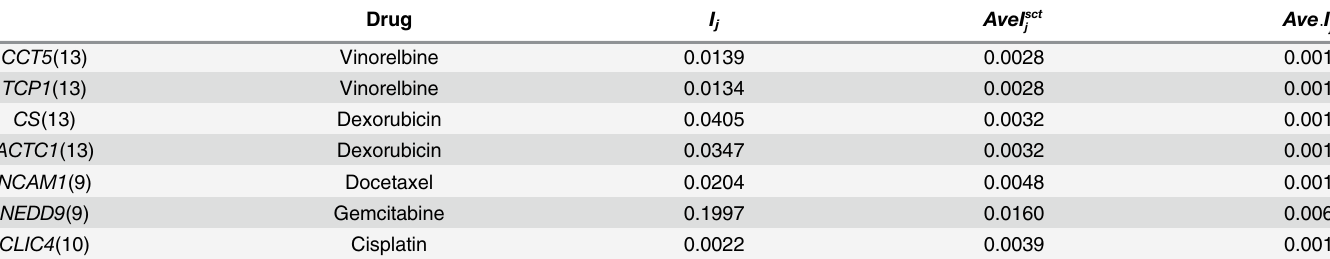
Table 5. Importance measures for gene with large